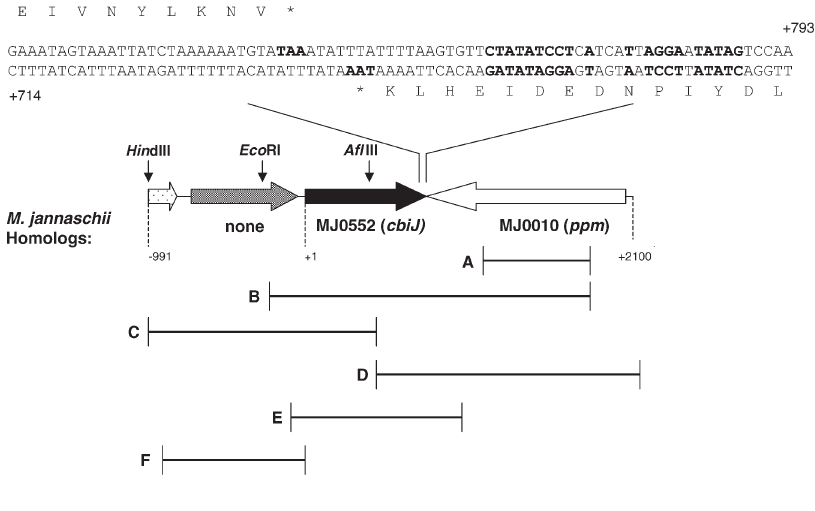
Figure 1. Map of the genes downstream of the ppm homolog of Methanococcus maripaludis strain JJ. Numbering of the DNA sequence begins with the putative start codon of cbiJ . The nucleotide se- quences of the termination regions of cbiJ and the ppm homolog are shown on the top. The bold characters in the sequences indicate potential termination codons and stem loop structures. The Hin dIII and Eco RI sites were used for identification of the flanking sequences of cbiJ . The Afl III site was used in the construction of pWDK117-14. A . The region of genomic DNA cloned in pWDK117-11. B . The re- gion of genomic DNA cloned in pWDK117-12. C . The region of genomic DNA cloned in pWDK117-13. D . The re- gion of genomic DNA from the auxotroph JJ117 cloned in pWDK117-14. E . The re- gion deleted in JJ121 following gene re- placement. F . The region used as a probe for the Southern blots of JJ121 and